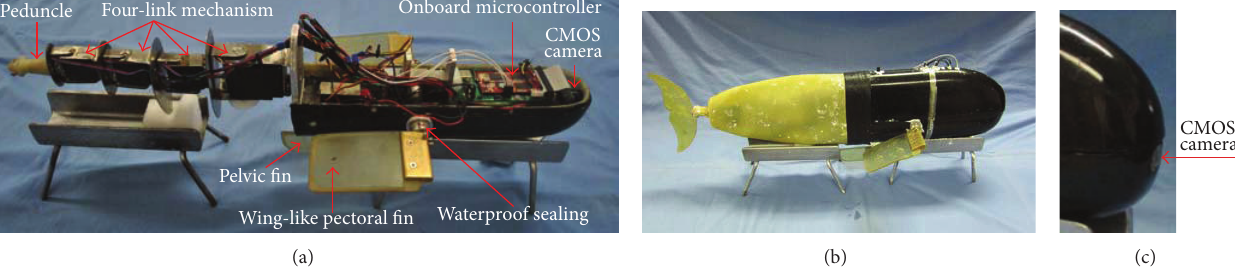
Figure 2: Photograph of the developed robotic prototype. (a) The assembled prototype. (b) The final prototype. (c) A feature of the onboard